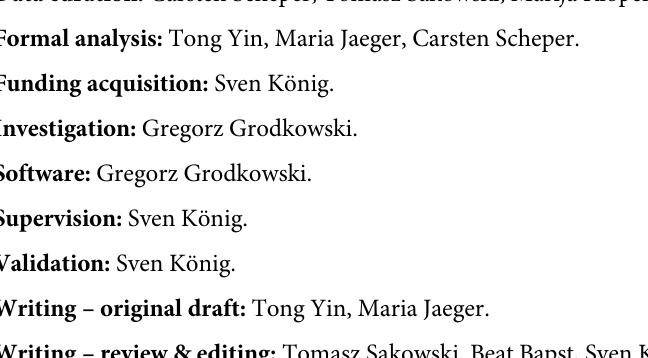
S2 Table. Genetic (above diagonal) and phenotypic (below diagonal) correlations among sensor behavior. Correlations estimated from bivariate models with the same fixed and ran- dom effects as model (1) and standard errors in brackets. RUM = rumination; FEED = feeding; BACT = basic active; HACT = high active; NACT = not active; ET = ear tem- perature; WEL-IP = welfare index point; WEL-IC = welfare index class; nc = did not